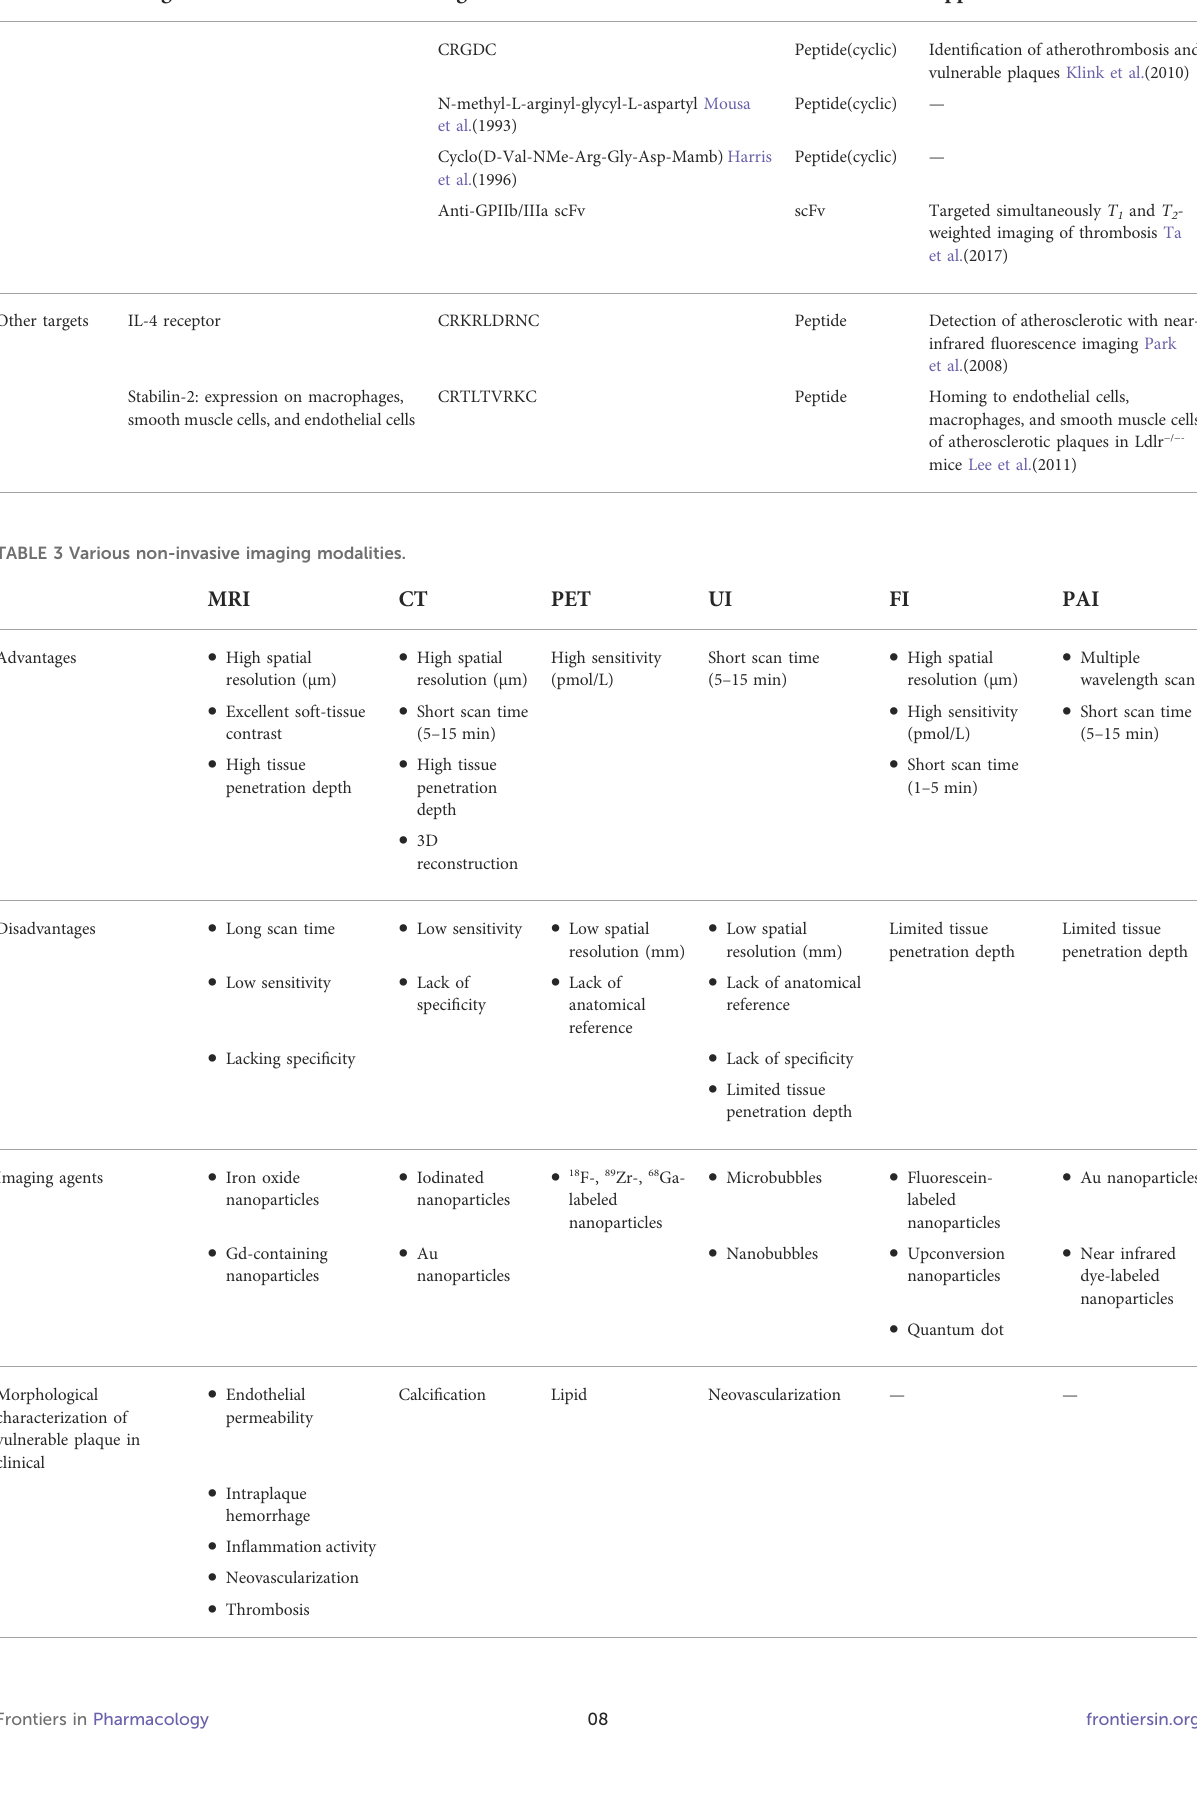
TABLE 2 ( Continued ) Diversity of current ligand – receptor systems.